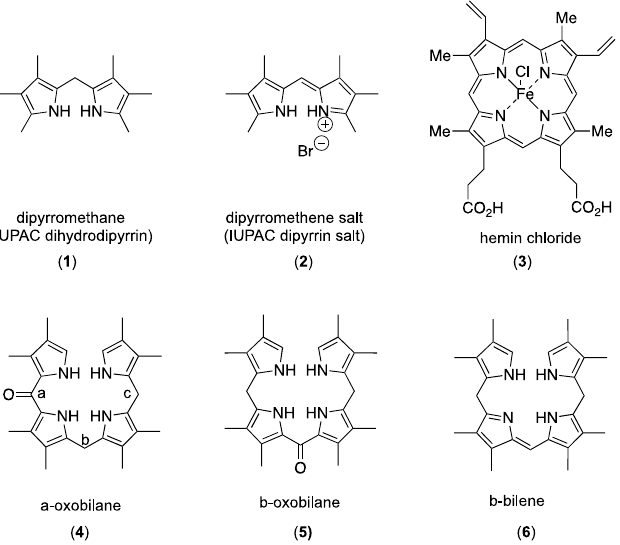
Figure 1. Structures of various porphyrin precursors and hemin chloride ( 3 ).